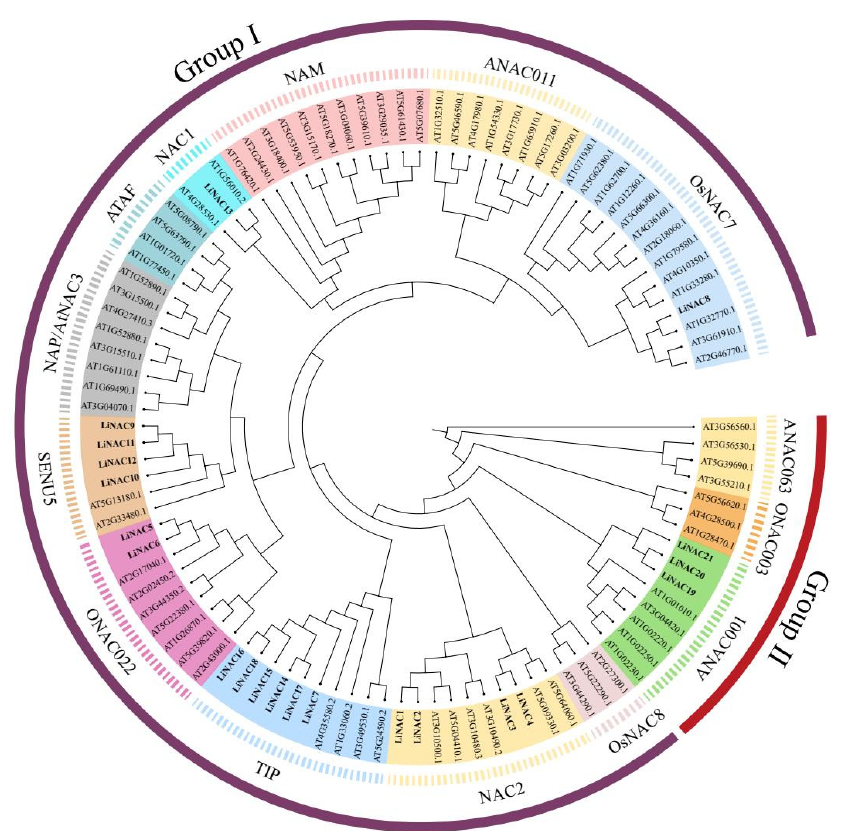
Figure 1. NAC phylogenetic tree of L. indica and A. thaliana . Each subgroup is distinguished by a different color.